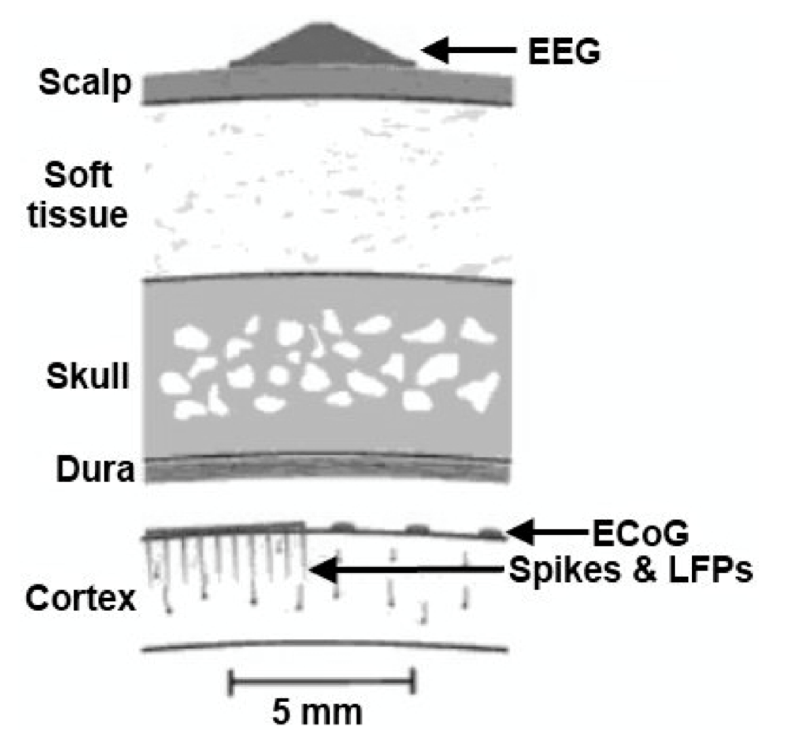
Figure 7. Layers the EEG signals have to go through